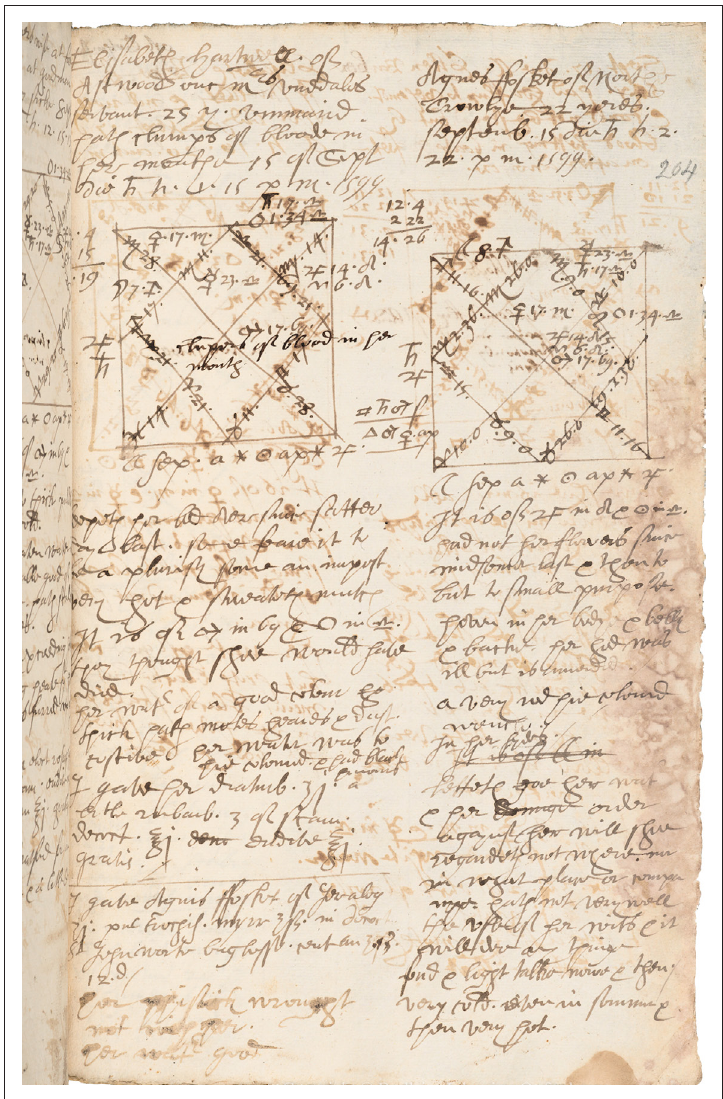
Figure 3: A page from Richard Napier’s casebooks, MS Ashmole 228, f. 204r, Bodleian Library, Oxford, https://cudl.lib.cam.ac.uk/view/MS-ASHMOLE-00228/417 (accessed 27 June 2019). © Bodleian Library, University of